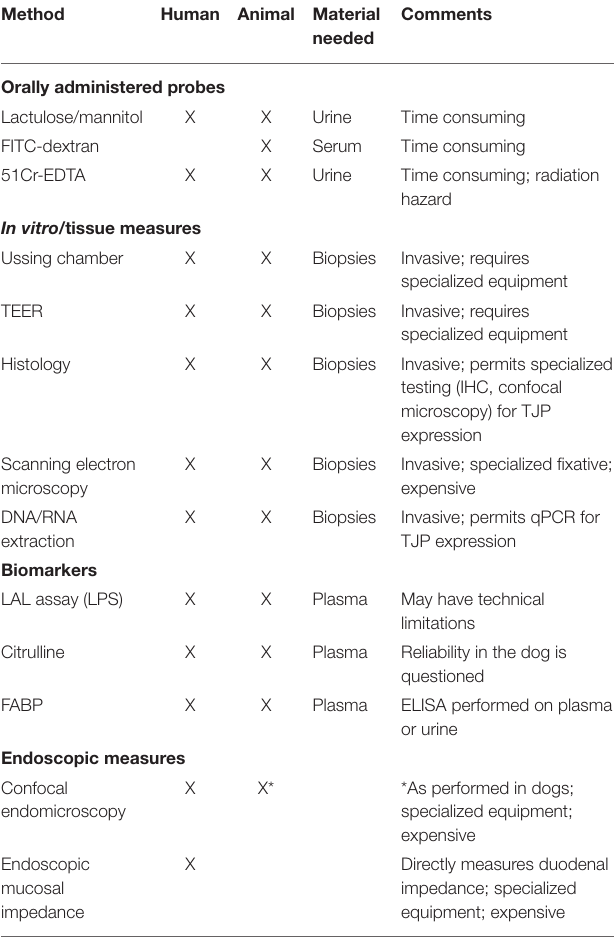
TABLE 2 | General means for assessment of intestinal permeability in humans and